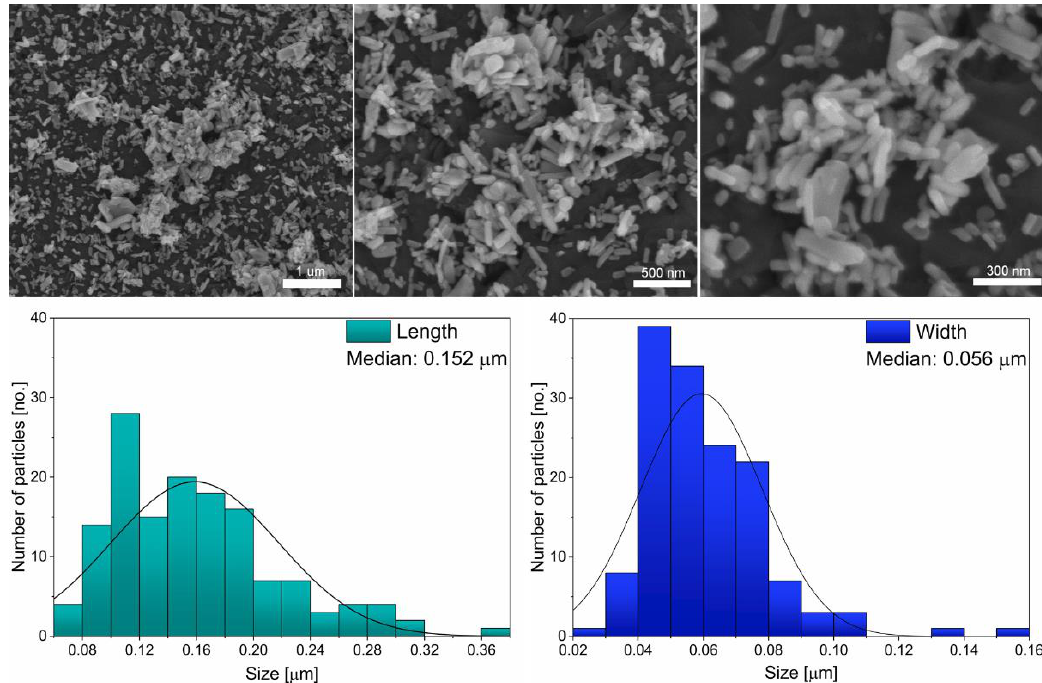
Figure 2. Scanning electron microscope (SEM) images (top) obtained for the investigated fluorapatite with its size distribution (bottom).